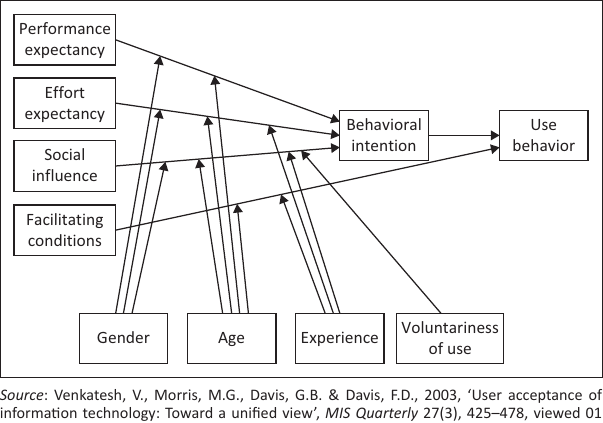
FIGURE 1: Unified Theory of Acceptance and Use of